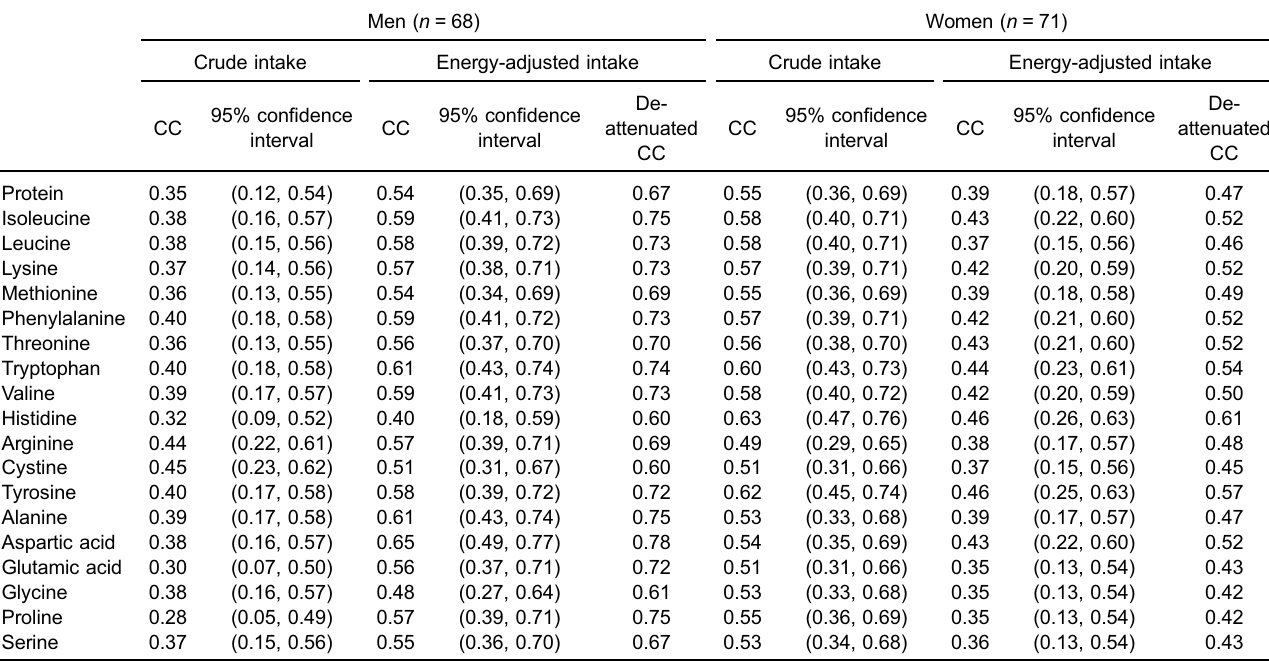
Table 3. Spearman rank correlation coef fi cients of amino acid intake from dietary records and a food frequency questionnaire